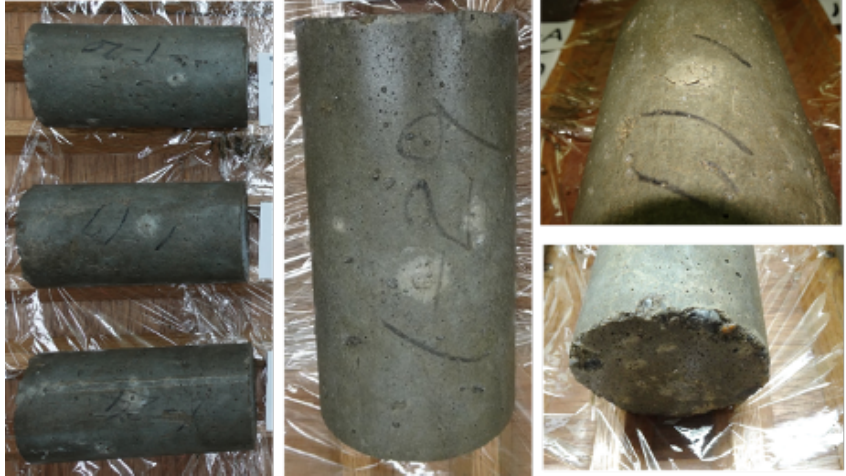
Table 1. The concrete mix.